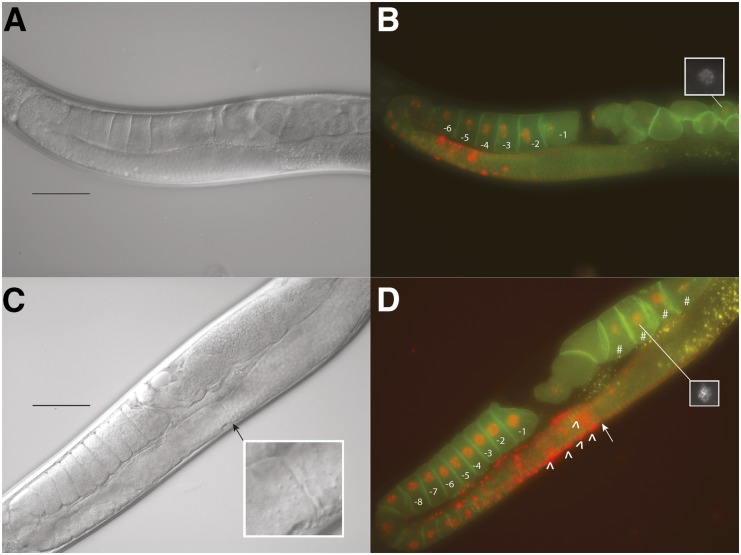
Gonad and oocyte morphologies of hlh-25(ok1710) animals. Nomarski (A, C) and merged fluorescent (B, D) images of representative gonad architecture and oocyte morphology in wild-type animals (A, B) as analyzed in a strain coexpressing a fluorescent chromosome marker (mCherry-Histone H2b) and a marker targeting green fluorescent protein to the plasma membrane (PI4,5P2) (Green et al. 2011), (B). Representative gonad architecture and oocyte morphology in hlh-25(ok1710) animals (C, D). Phenotypes include increased oocyte number, distal gonad arm constriction (arrow), increased apoptosis (^), and arrested embryos in uterus (#). Insert in (C) shows magnified view of distal gonad arm constriction. Inserts in (B) and (D) show embryonic nuclei. In all images, ventral is up, anterior is to the right, scale bar = 50 µm.